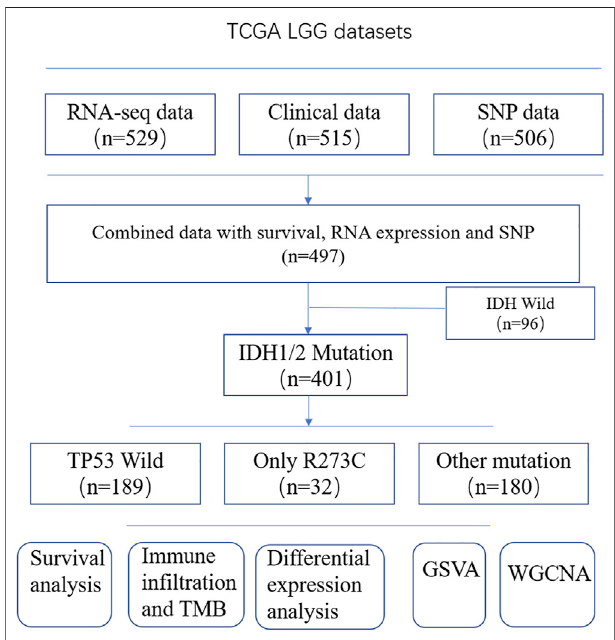
FIGURE1 | Study fl owchart. Patients ( n = 9) whose TP53genes contain not only R273C mutation but also other mutations were included in the other mutation